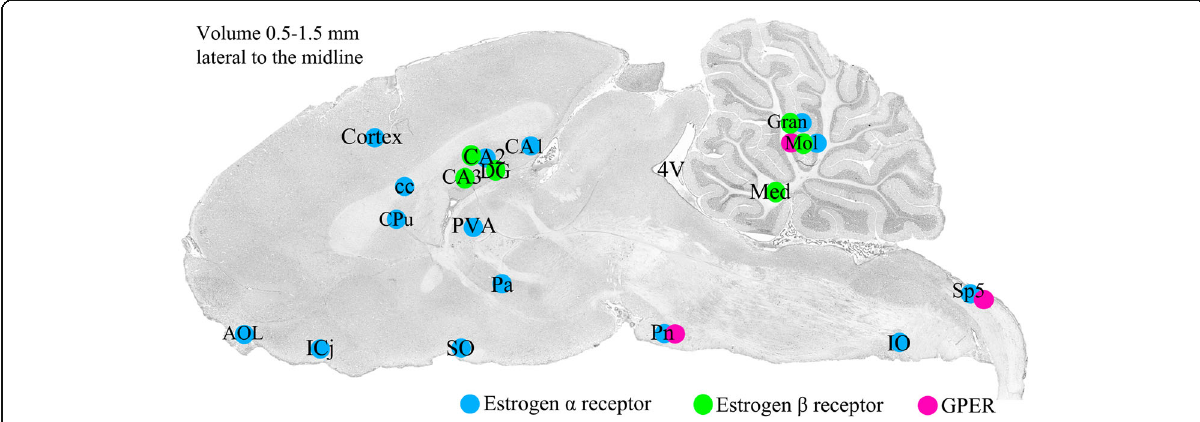
Fig. 1 Sagittal cryo-sections stained with Hematoxylin and Eosin. The 6th edition of The Rat Brain in Stereotaxic Coordinates by Paxinos and Watson [23] was used to identify the different areas. Blue color denotes ER α receptor green color ER β receptor and pink color GPER